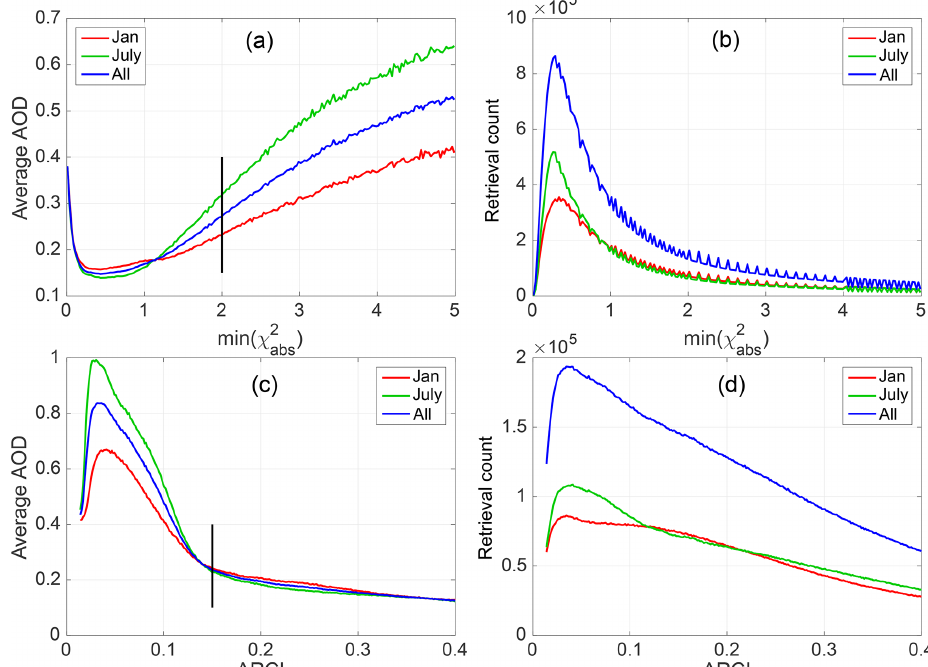
Figure 3. Histograms of average AOD as a function of (a) min( χ 2 both months combined. Panels (b) and (d) are histograms of retrieval counts corresponding to min (χ 2